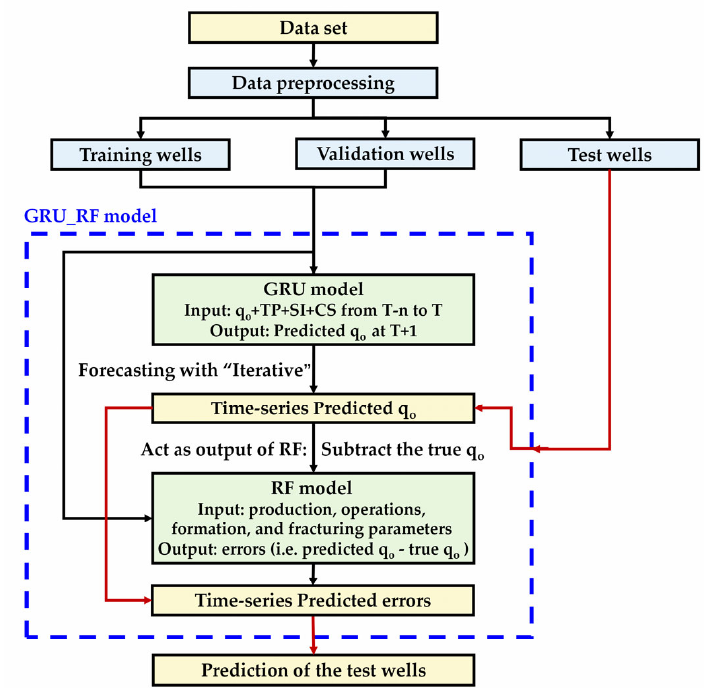
Energies 2020 , 13 , x FOR PEER REVIEW Figure 16. The overall workflow of the proposed GRU_RF model. Figure 16. The overall workflow of the proposed GRU_RF model.